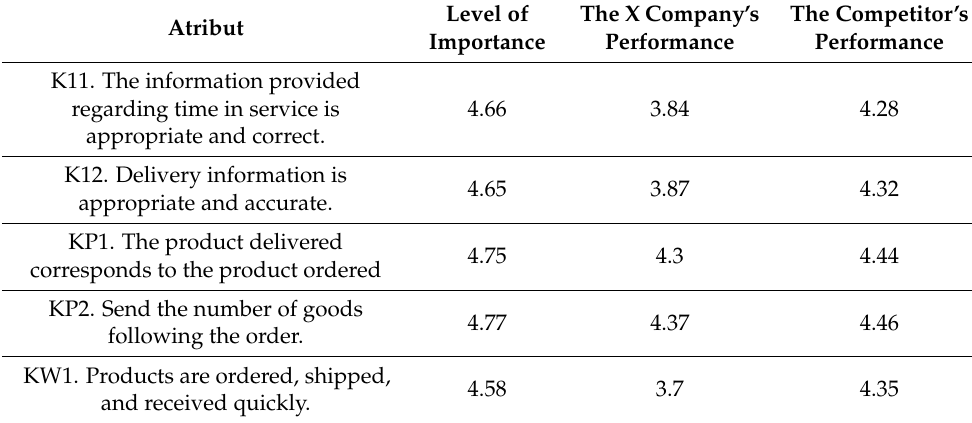
Table 9. The average value of importance level and service attribute